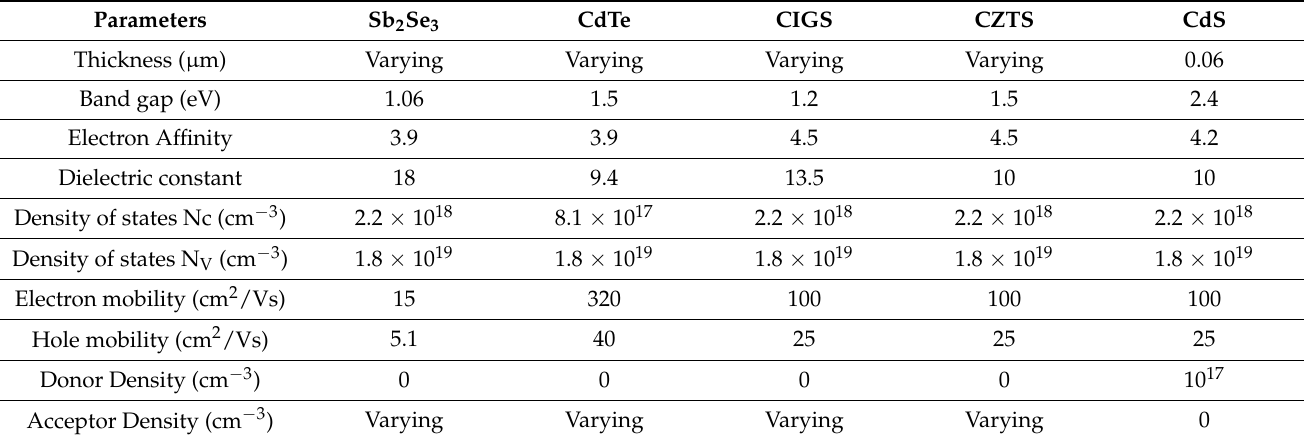
Figure 1. Schematic of various absorber layer-based solar cell. Table 1. Schematic of various layers of CdTe/CIGS/CZTS/Sb 2 Se 3 -based solar structure.